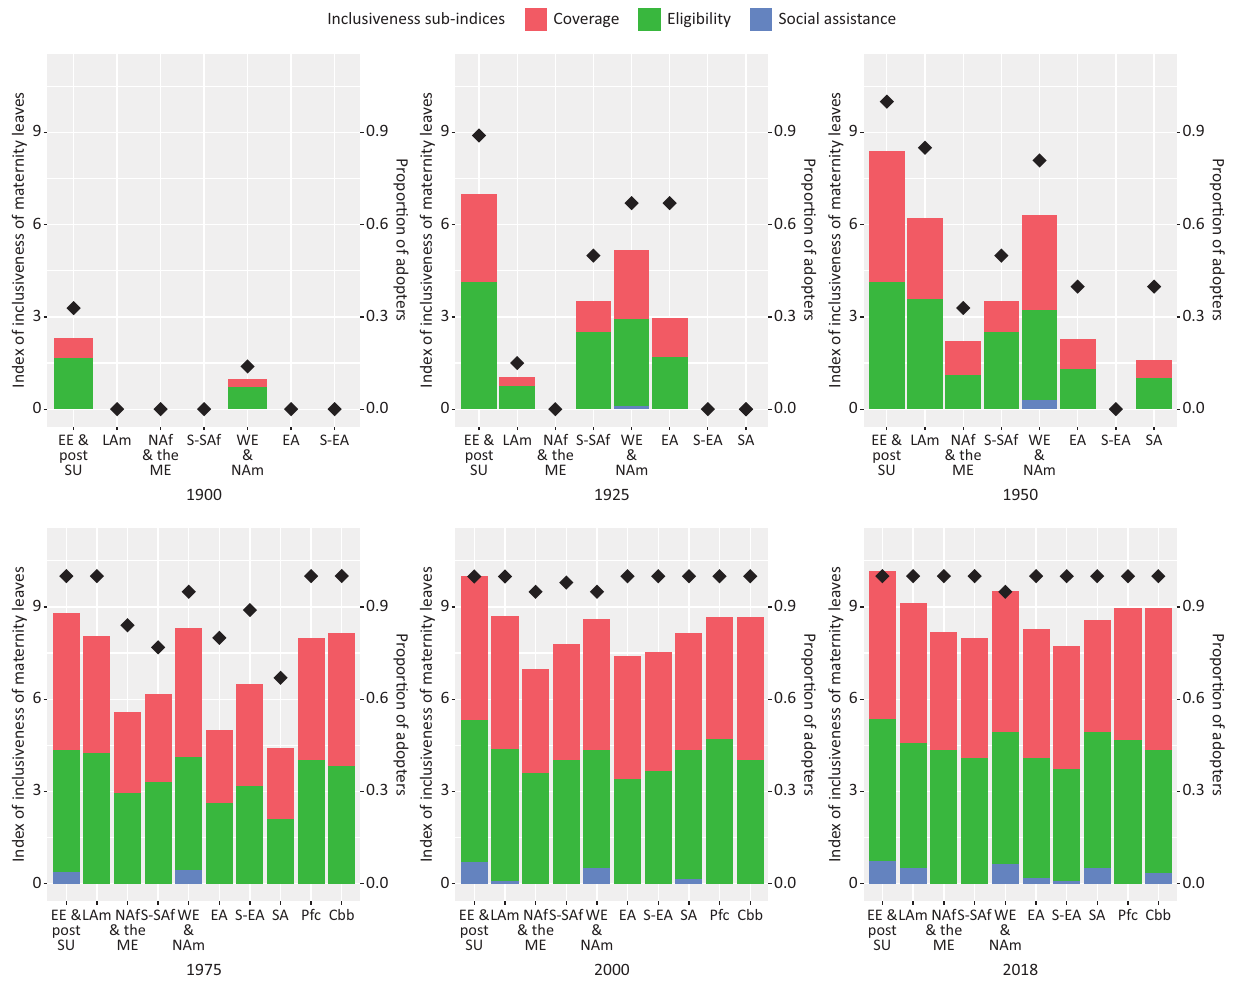
Figure 1. Regional pattern of adoption and index of inclusiveness of maternity